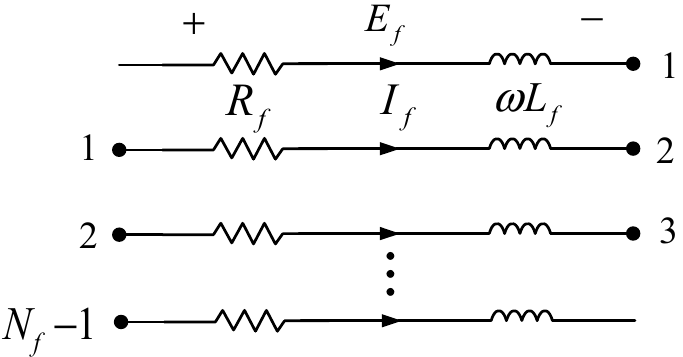
Figure 6. Illustration of inter-turn SC.